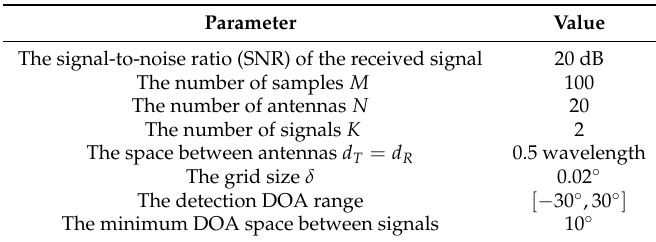
Figure 3. DOA estimation performance with different numbers of phase errors. Table 1. Simulation